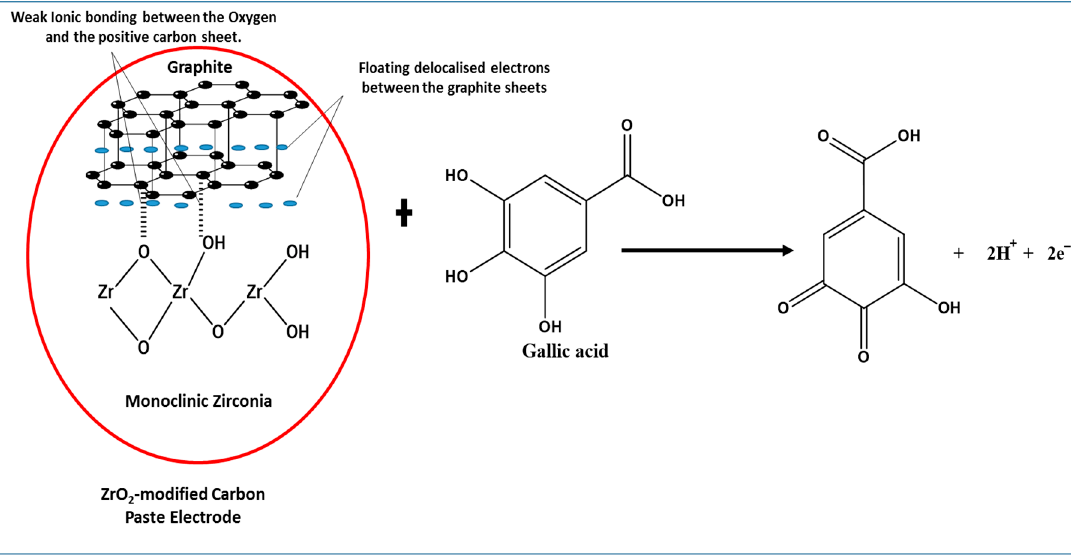
Figure 12. Proposed interaction between ZrO 2 nanoparticles (monoclinic zirconia) and graphite, showing a weak ionic bond between some of the oxygen and the positive graphite sheet, towards electrochemical determination of gallic acid.